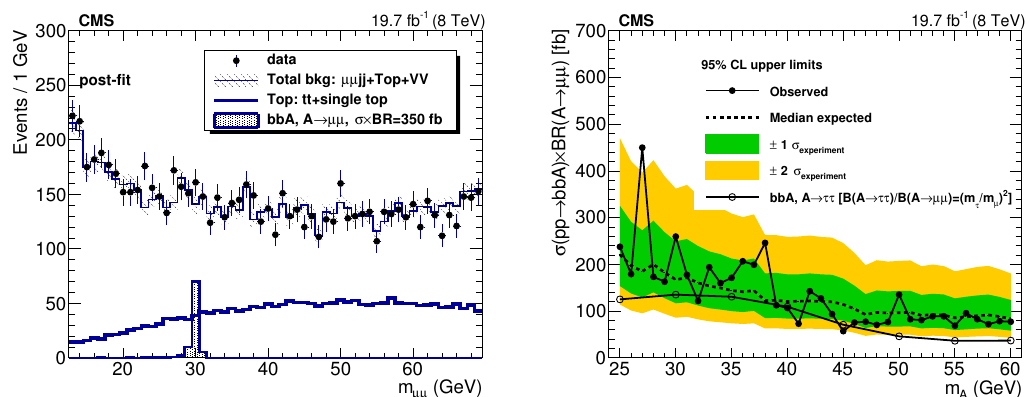
Figure 5 . Left: the dimuon mass distribution with the post-(cid:12)t background event yield and its uncertainty given by the (cid:12)t, and the expected signal for m A = 30 GeV assuming a signal cross section times branching fraction of 350 fb. Right: expected and observed upper limit at 95% CL on (cid:27) (pp ! bbA) B A ! (cid:22)(cid:22) ) as a function of m A . The open circles show the limits obtained in the CMS analysis of the A ! (cid:28)(cid:28) (cid:12)nal state [8] when translated into limits for the A ! (cid:22)(cid:22) (cid:12)nal state using eq.